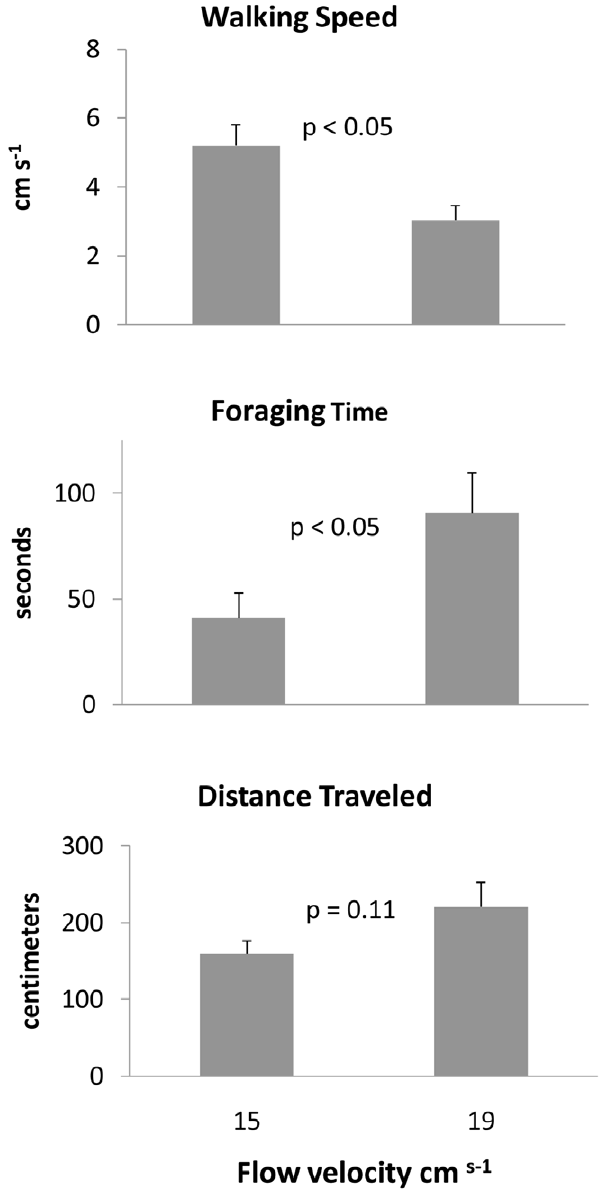
Figure 3. Behavioral parameters measured in flume assays of successfully foraging green crabs in two flow velocities. Graphs show mean ( 6 SE) of: walking speed (cm s 2 1 ), foraging time (seconds), and total distance traveled (centimeters). T-tests were performed for each parameter, p values are shown on each graph with significance a a =0.05, and n=10.